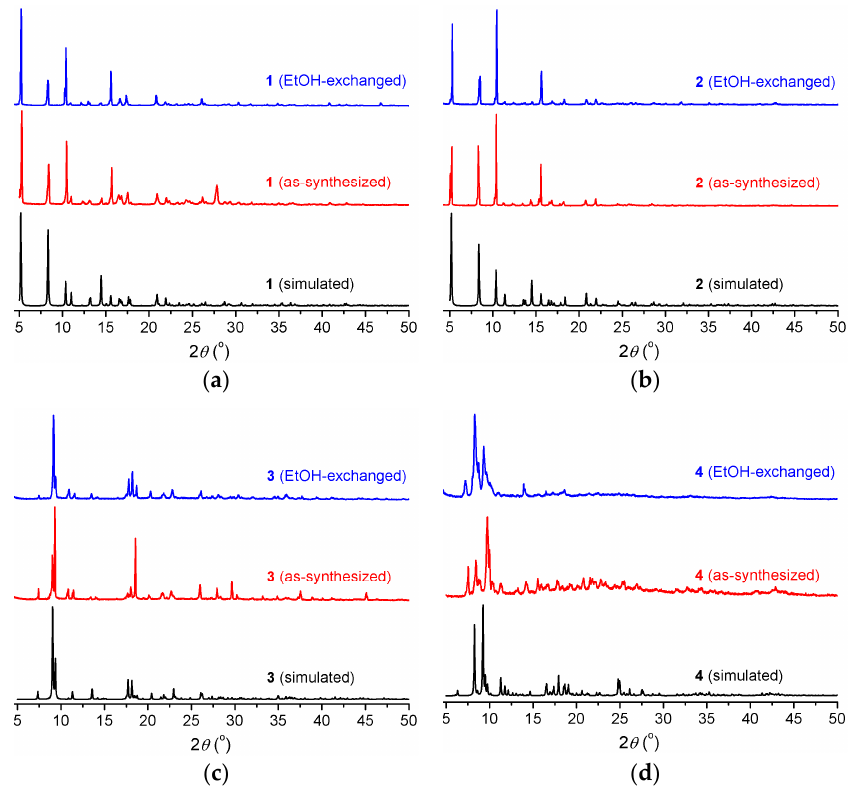
Figure 4. Powder X-ray diffraction (PXRD) patterns of simulated, as-synthesized, and EtOH-exchanged Polymers 2018 , 10 , x FOR PEER REVIEW Figure 4. Powder X ‐ ray diffraction (PXRD) patterns of simulated, as ‐ synthesized, and EtOH ‐ exchanged compounds ( a ) 1 , ( b ) 2 , ( c ) 3 , and ( d ) 4 . compounds ( a ) 1 , ( b ) 2 , ( c ) 3 , and ( d ) 4 .